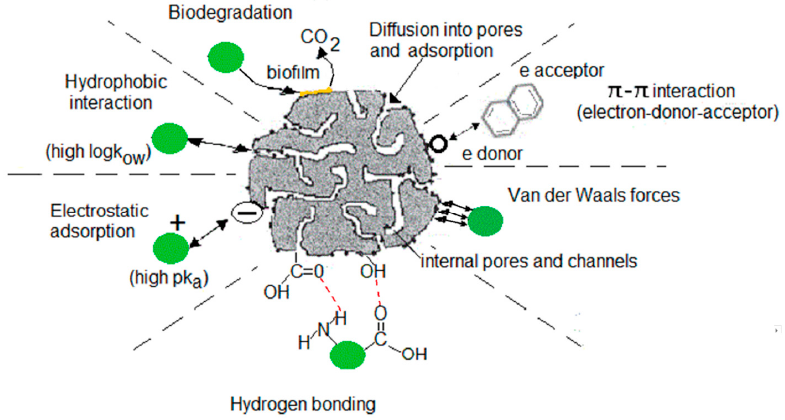
Figure 2. Possible mechanisms for removal of PPCPs from wastewater using the AC adsorption process (modified from Loganathan et al. [53]).